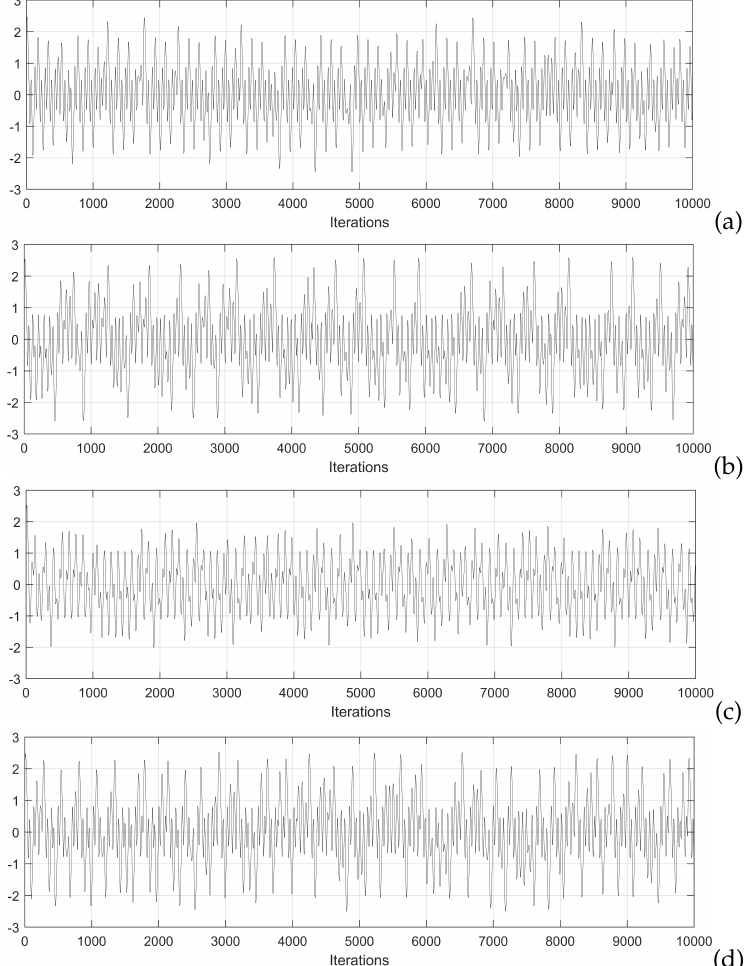
Figure 6. Chaotic time series generated by using the sets of values listed in Table 2: ( a ) original,